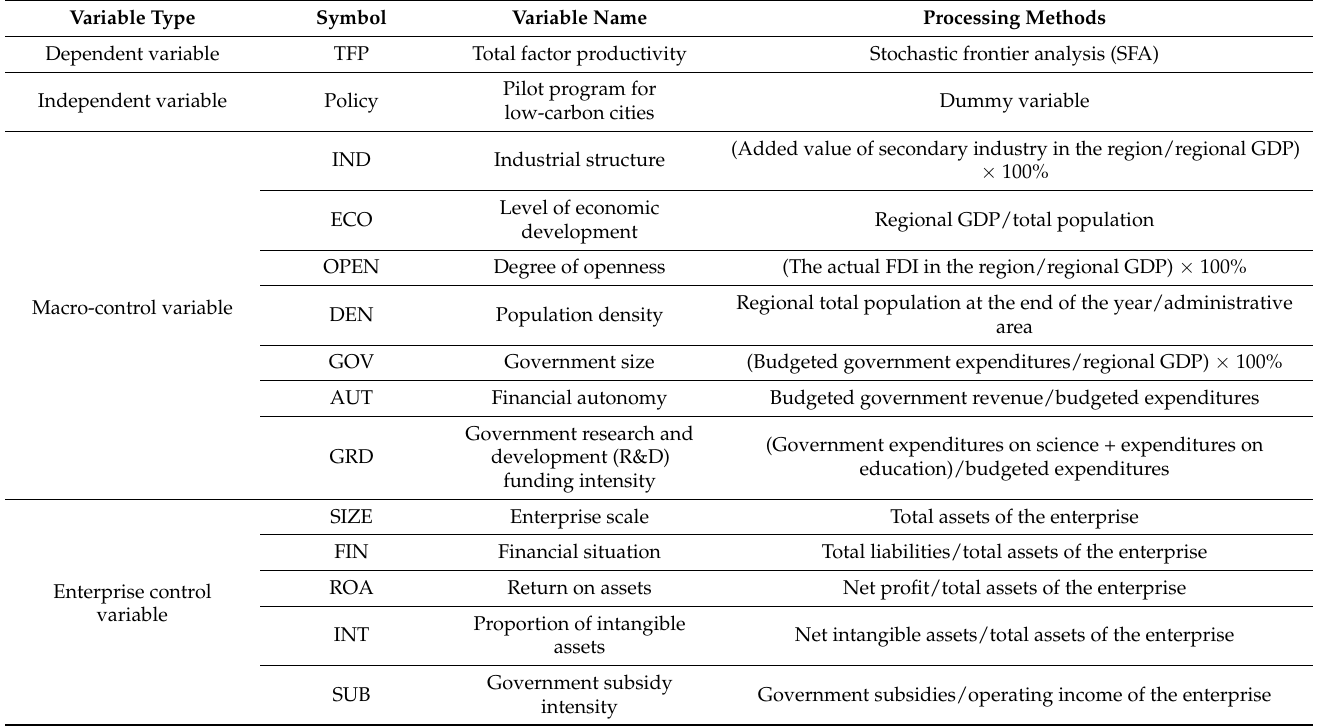
Table 1. Primary variables and processing